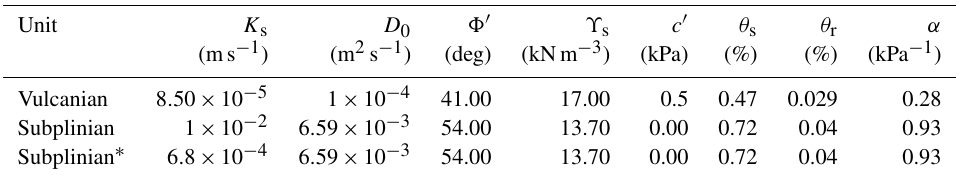
Table 3. Input parameters for the subplinian ( K s from the literature), subplinian ∗ ( K s measured in the field), and 1888–1890 Vulcanian eruption scenarios used for simulation with